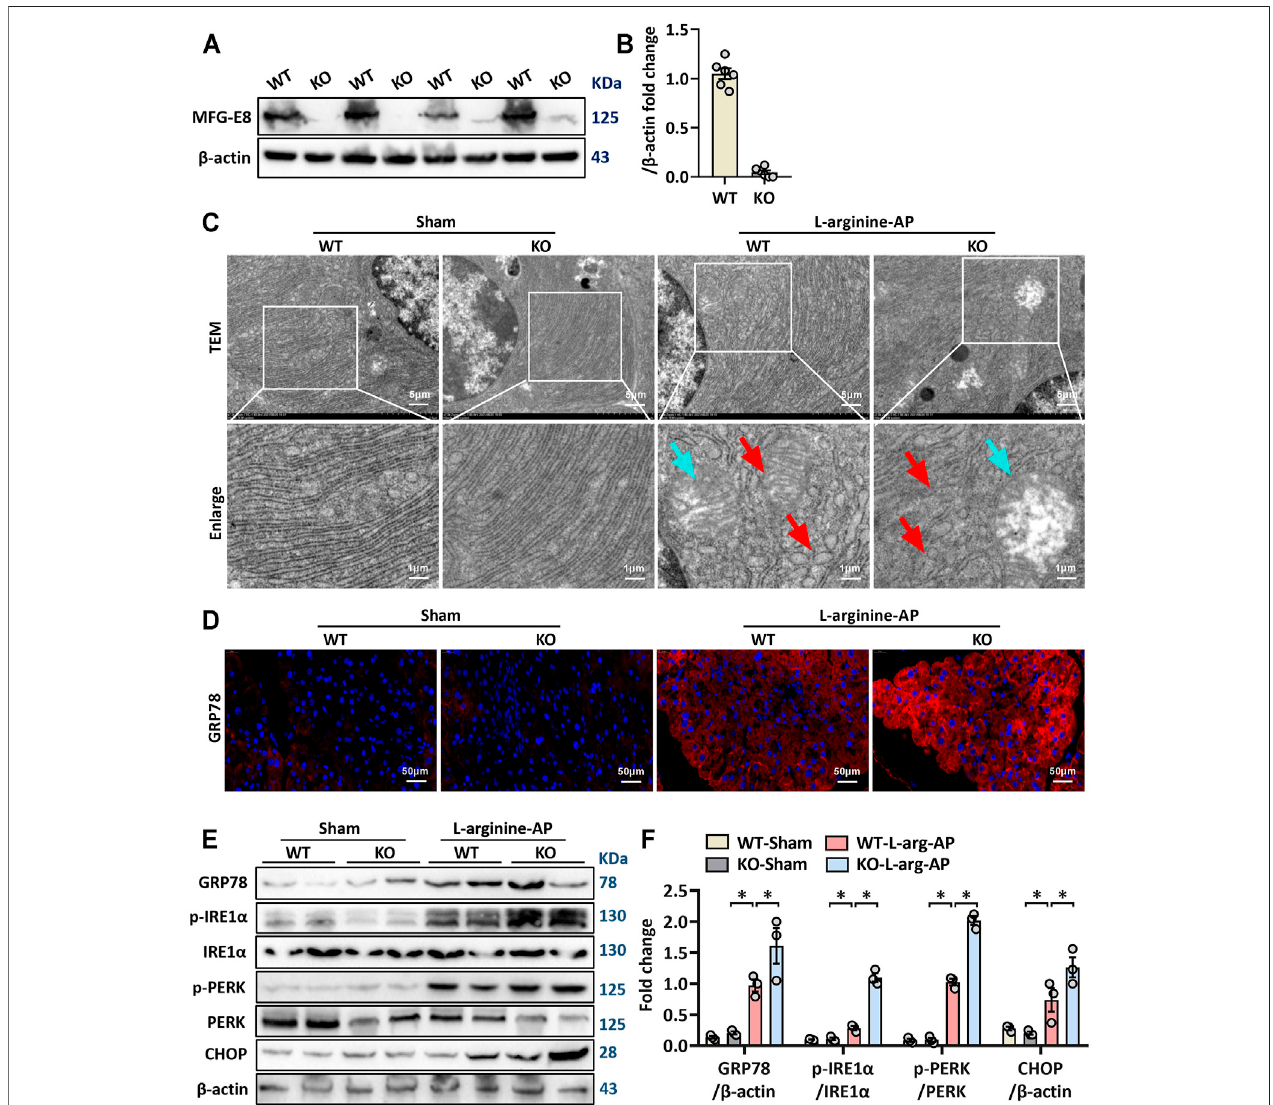
FIGURE 4 | MFG-E8 de fi ciency aggravated pancreatic ER stress in L-arginine-treated mice. In mice, arginine-AP stress was induced by 2 hourly intraperitoneal injections of 4.0 g/kg L-arginine. At 2 h after the last injection of L-arginine, normal saline (vehicle) or 20 μ g/kg MFG-E8 were administered through intraperitoneal injection. The animals were sacri fi ced at 69 h after MFG-E8 treatment (i.e., 72 h after the fi rst injection of L-arginine). Blood and tissue samples were collected. (A,B) Western blot analysis of the expression of MFG-E8 in the pancreas; (C) Ultrastructural alterations in the pancreas (Transmission electron microscopy); (D) Representative photos of GRP78 staining; (E,F) Western blot analysis of the expression of GRP78, phospho-PERK, PERK, phospho-IRE1 α , IRE1 α and CHOP in the pancreas. n (cid:1) 4 – 6/group, error bars indicate the SEM; p p < 0.05 versus Sham group; # p < 0.05 versus Vehicle group. WT, wild type; KO, knockout; MFG-E8, milk fat globule EGFfactor 8;AP,acutepancreatitis;GRP78,glucose-regulatedprotein 78;CHOP, C/EBPhomologousprotein; PERK,PKR-likeendoplasmicreticulumkinase.